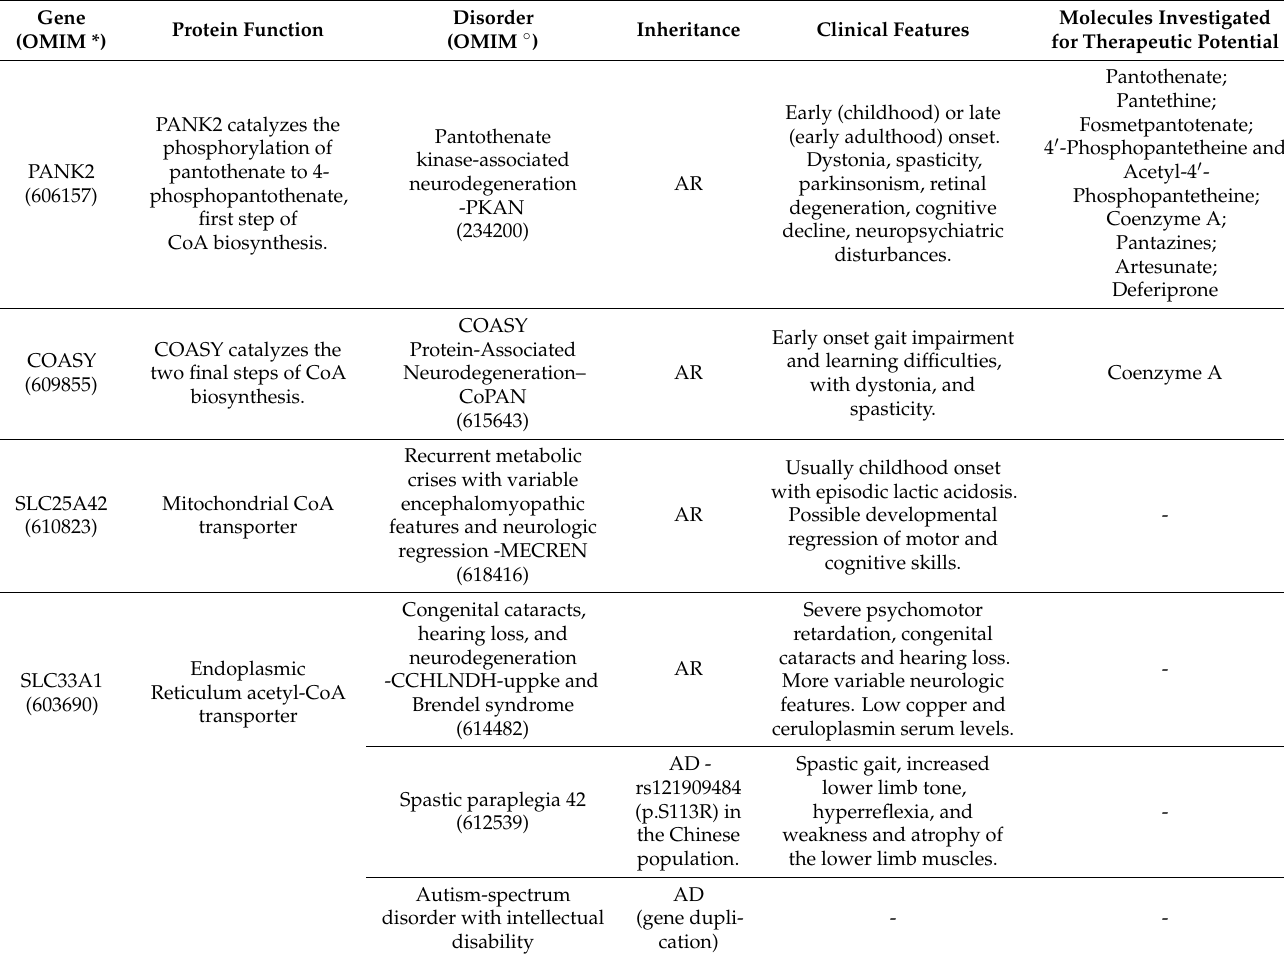
Molecules Investigated for Therapeutic